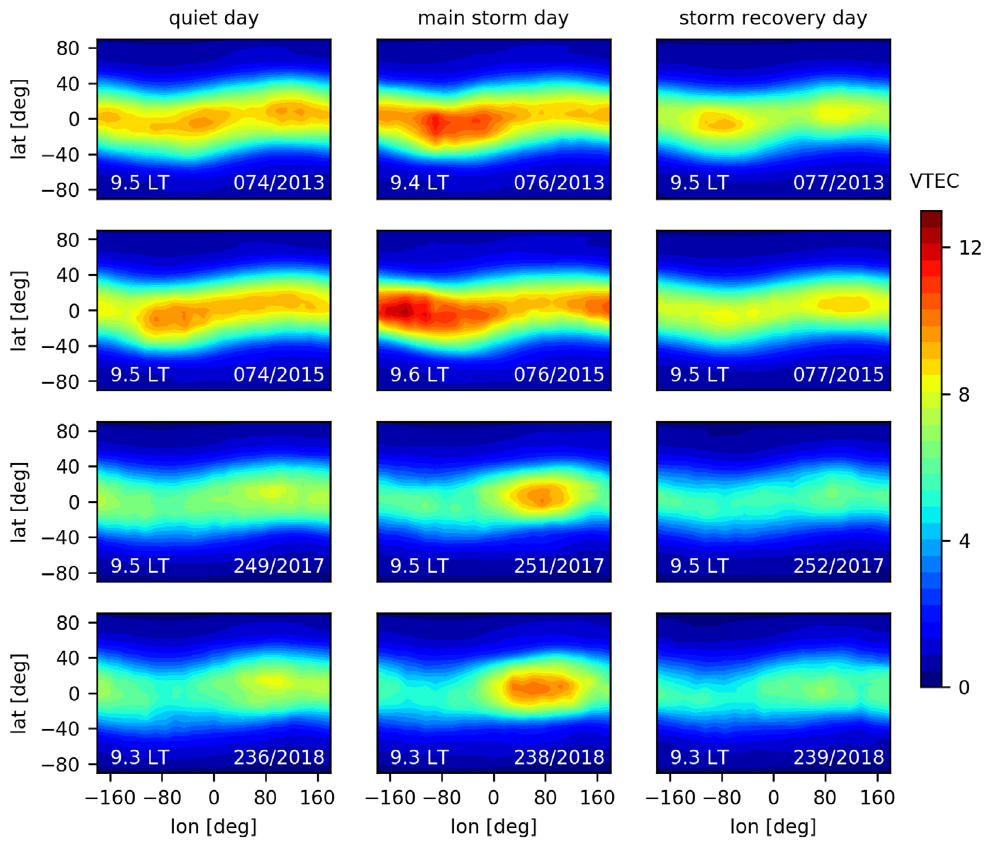
Fig. 4. Daily VTEC maps above LEO orbit height during analyzed storm days obtained with tomographic reconstruction based on METOP TEC measurements during satellite rising. The unit of the color bar is TECU and the given LT hour is computed in the equatorial region.